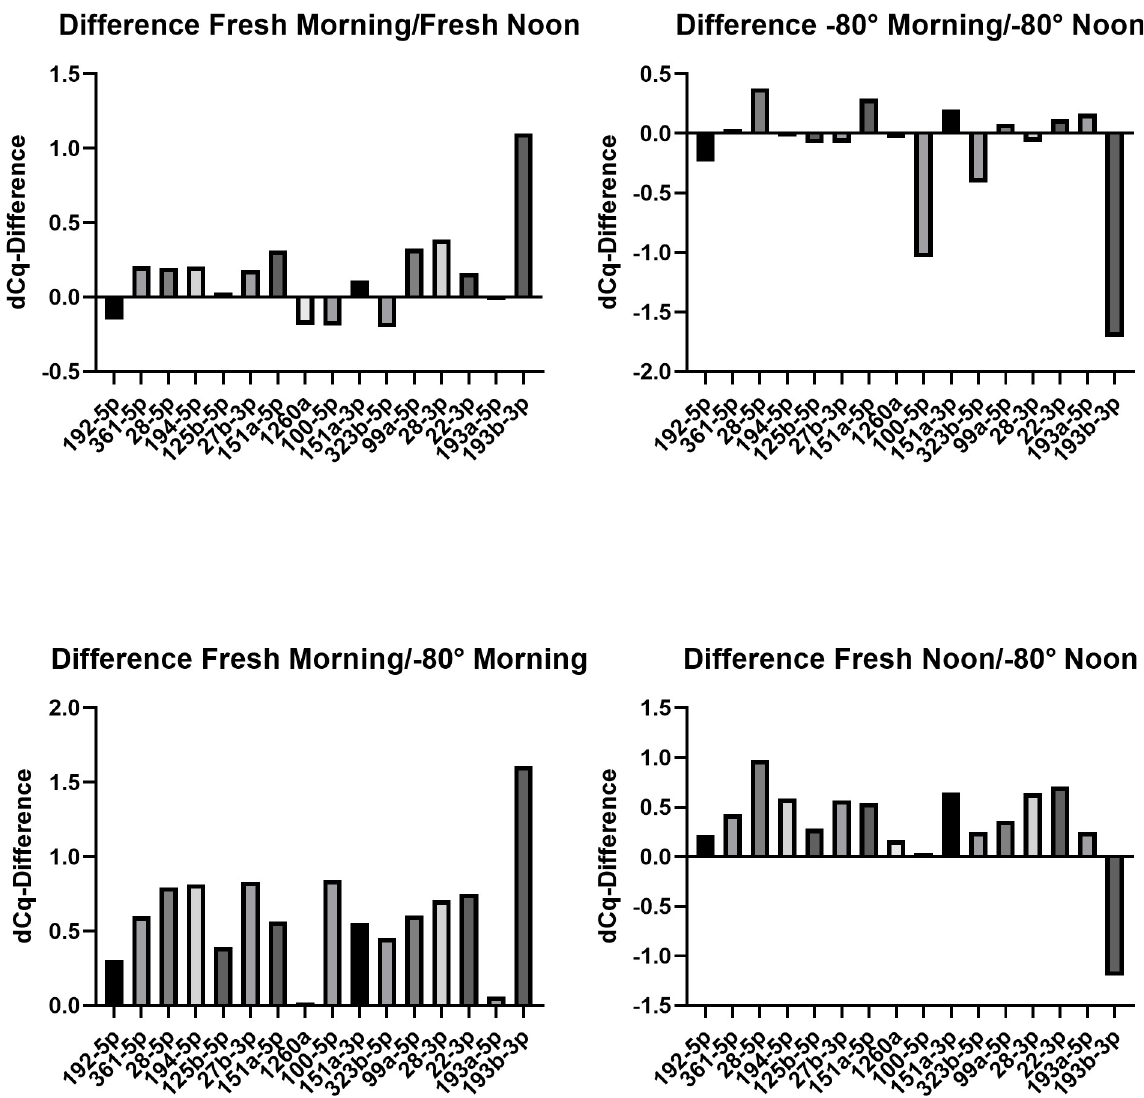
Fig 5. dCq differences. The dCq difference of all miRNA samples taken either in the morning under fasting condition and in the afternoon after normal eating and drinking. The dCq difference of the samples analyzed within 24h, as well as of the samples which were analyzed after 14 days storage at -80˚C as shown. Overall, there are small differences under 1 dCq. Just the miRNA 193b-3p shows differences in all samples more than 1 dCq and the sample of the difference -80˚C morning/ -80˚C noon by miRNA 100-5p shows the difference more than 1dCq.